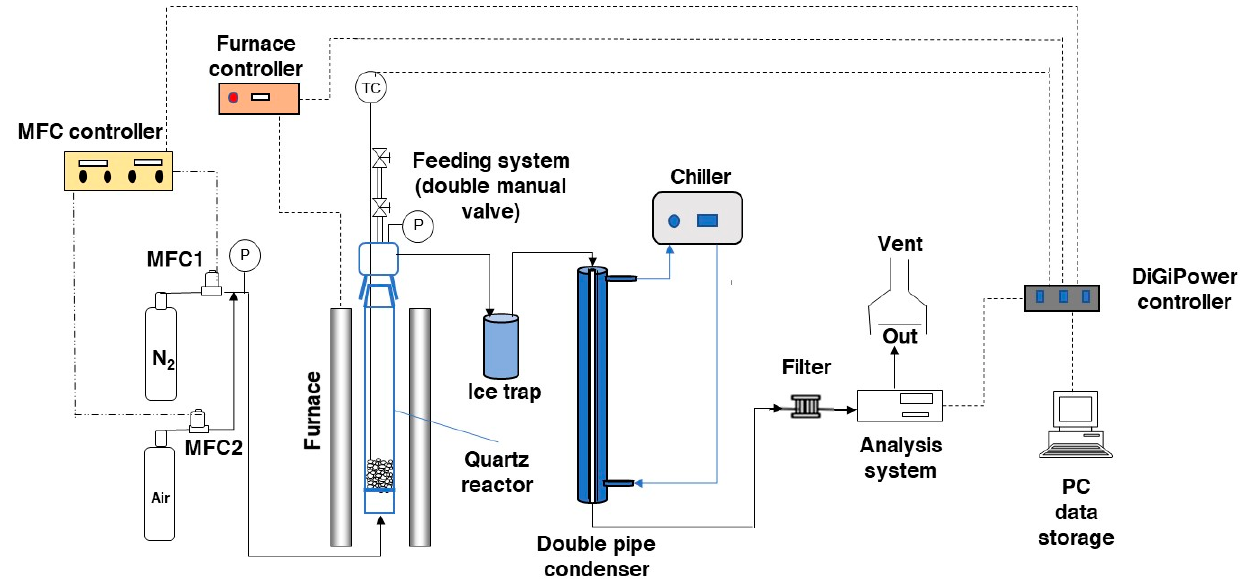
Figure 1. Schematic view of the laboratory-scale experimental apparatus for pyrolysis tests. A sintered porous quartz plate sustained the fluidized bed and served as a gas distributor. The bottom part of the reactor, underneath this quartz plate, was filled by a packed bed made of SiC particles; this bulk of SiC was placed inside the furnace, so to work as a preheater for the fluidizing N 2 flow. The masses of loaded OCs or sand were selected in order to obtain 7.5 cm high beds (1.5 times the bed diameter).